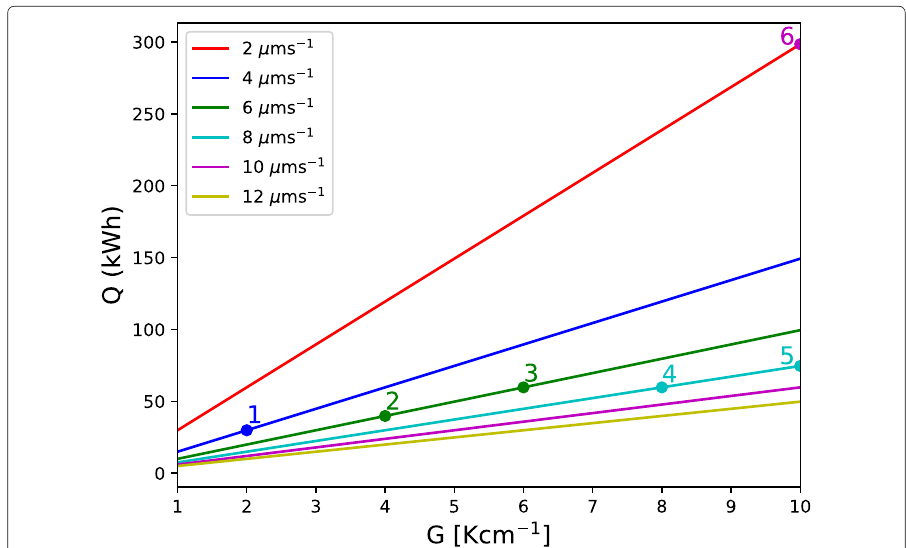
Fig. 12 Estimated energy consumption Q depending on growth velocity v and thermal gradient G. The process parameters according to Eq. 9 are indicated by the numbered